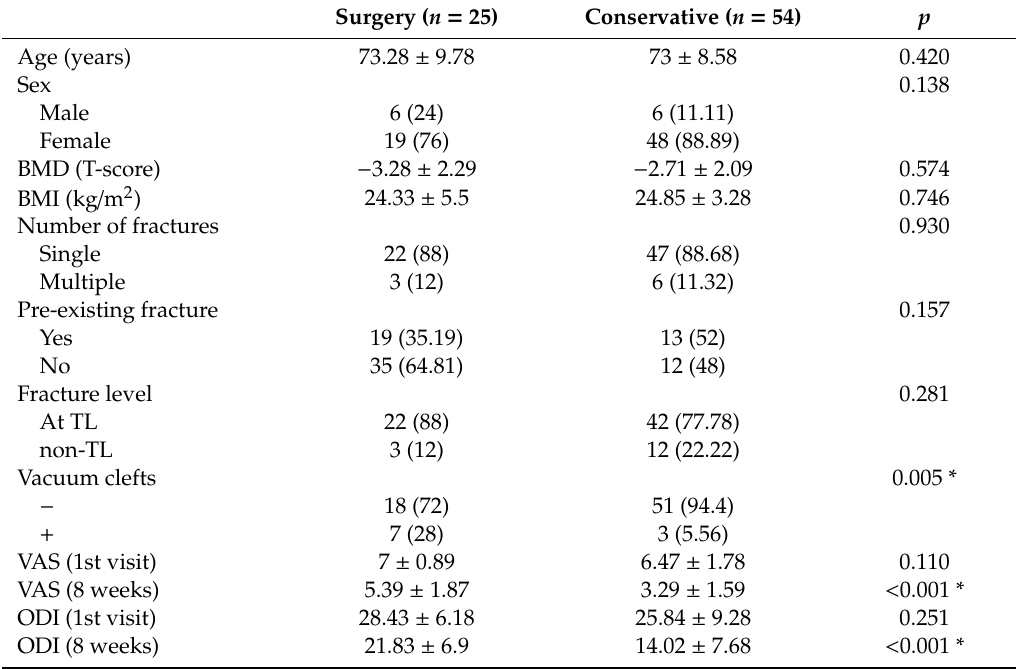
Table 1. Patient characteristics.